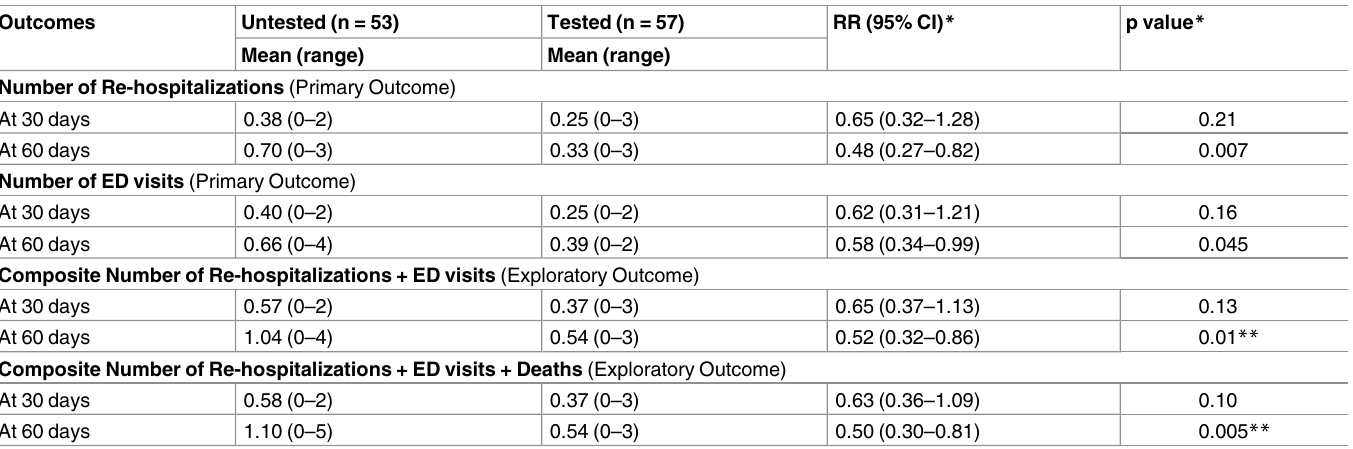
Composite Number of Re-hospitalizations + ED visits (Exploratory